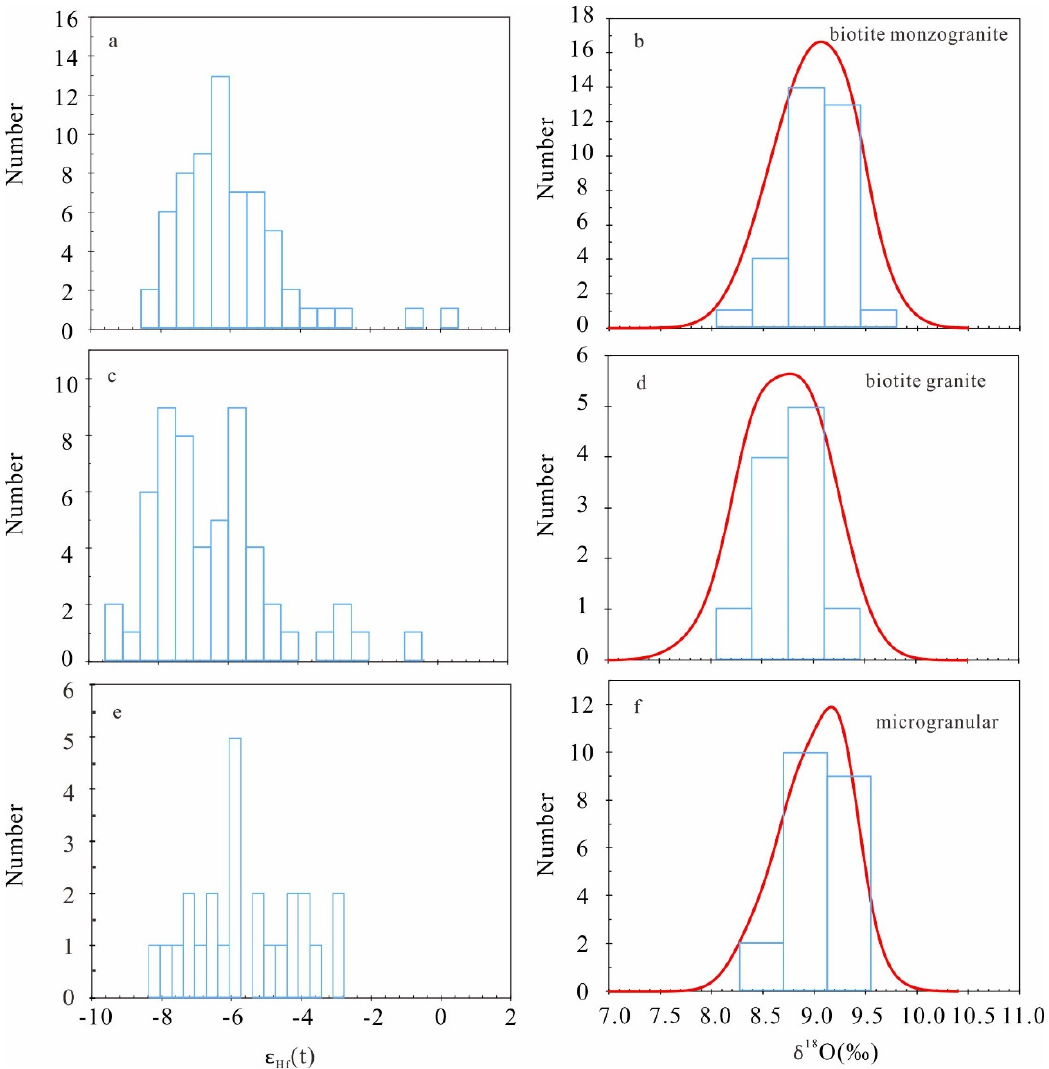
Figure 9 . The histogram of ε Hf (t) ( a , c , d ) and δ 18 O values ( b , e , f ) from the Xitian intrusion and MEs. Figure 9. The histogram of ε δ 18 O values ( b , e , f ) from the Xitian intrusion and Hf (t) ( a , c , d ) and